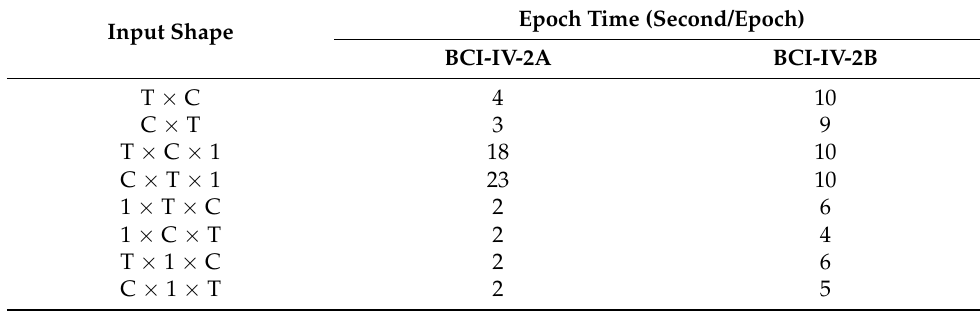
Table 3. Epoch times for each input shape for BCI-IV-2A and